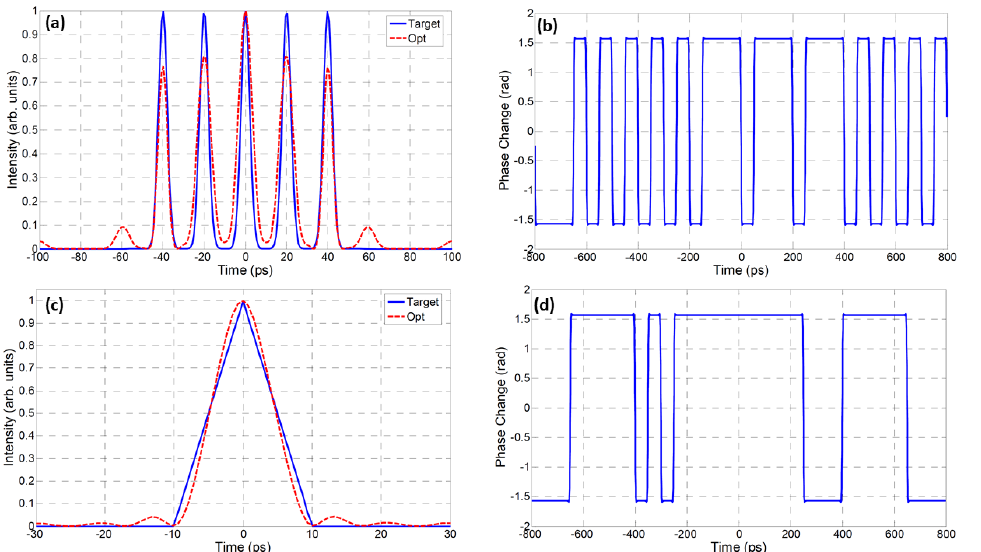
Figure 5. Target and optimized intensity profiles with the corresponding binary phase modulation for: ( a , b ) a (50 GHz) periodic sequence of 5 pulses and ( c , d ) a 20 ps triangular pulse intensity